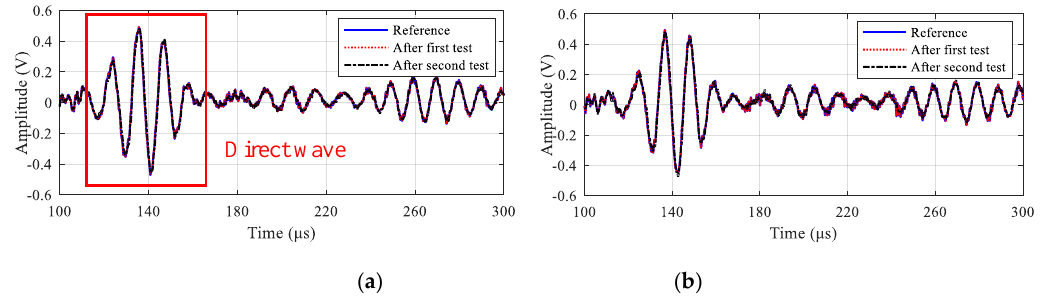
Figure 12. Signal comparison results of paths 2-6 and paths 3-5. ( a ) Paths 2-6. ( b ) Paths 3-5.